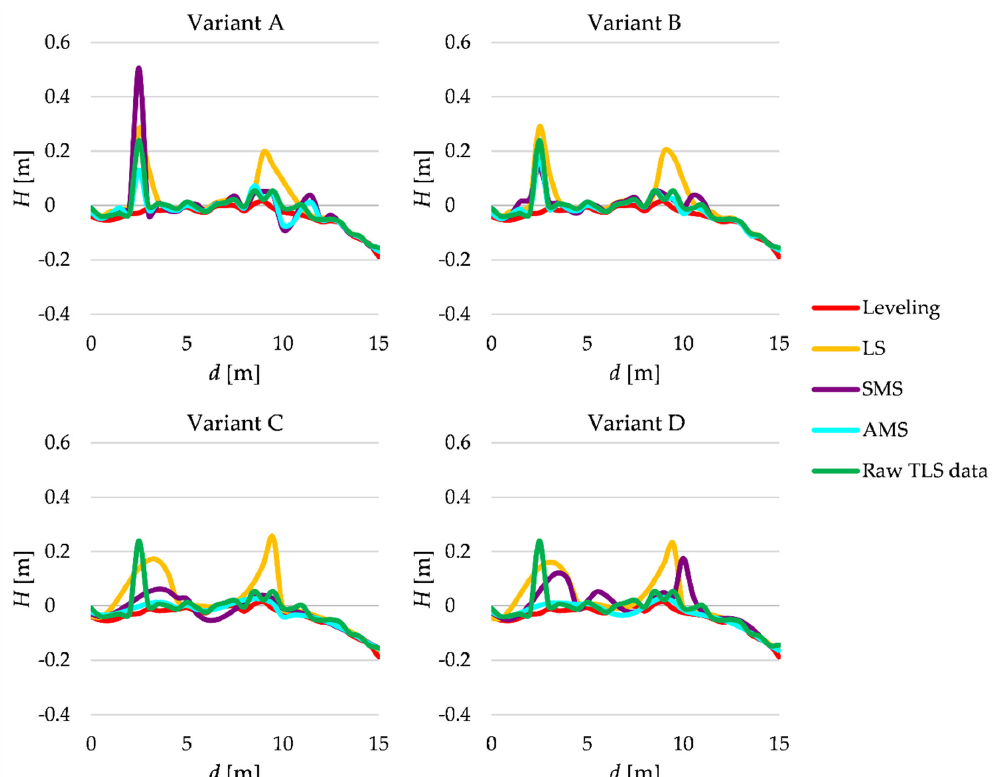
Figure 9. Estimated terrain profiles of line II.